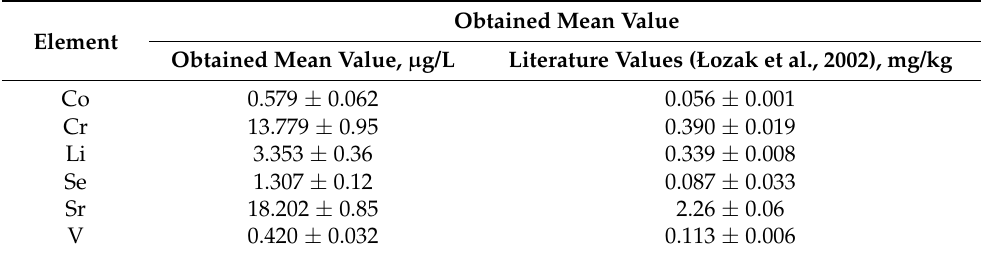
Table 6. The comparison of the obtained results (means, ( µ g/L) with the literature data [24] for Co, Li, Se, Sr, and V in the analyzed samples. Obtained Mean Value Element Obtained Mean Value, µ g/L Literature Values (Łozak et al., 2002), mg/kg Co 0.579 ± 0.062 0.056 ± 0.001 Cr 13.779 ± 0.95 0.390 ± 0.019 Li 3.353 ± 0.36 0.339 ± 0.008 Se 1.307 ± 0.12 0.087 ± 0.033 Sr 18.202 ± 0.85 2.26 ± 0.06 V 0.420 ± 0.032 0.113 ±